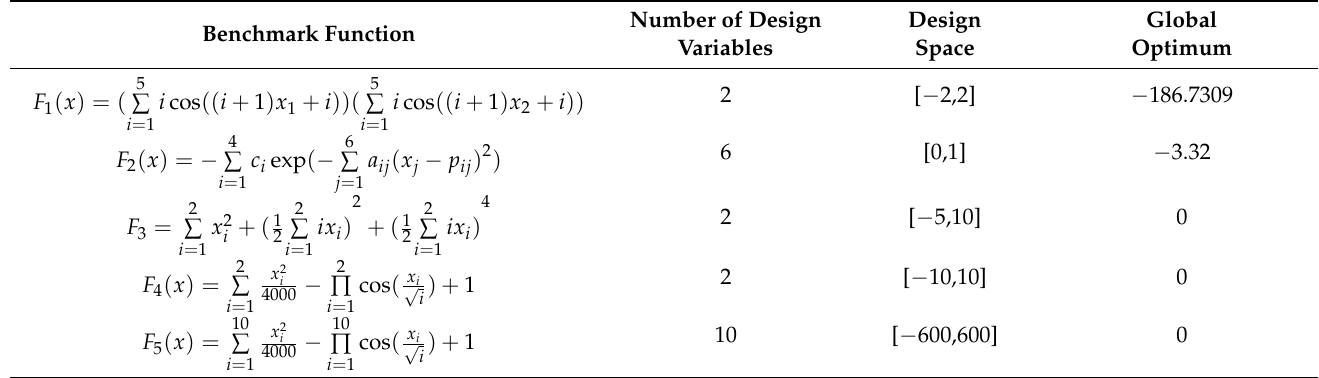
Table 3. Benchmark